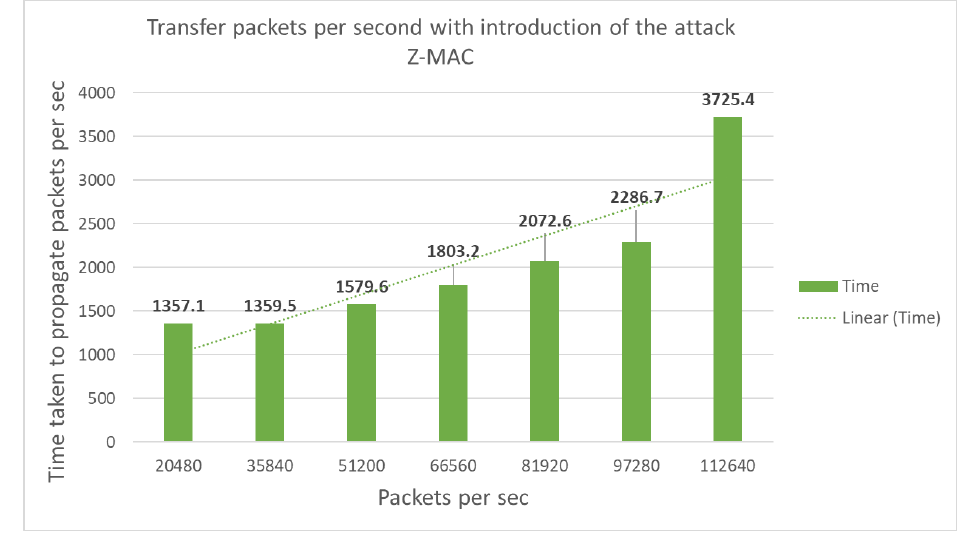
Figure 8. Total transmission time using the ZMAC scheme when an attack is introduced.